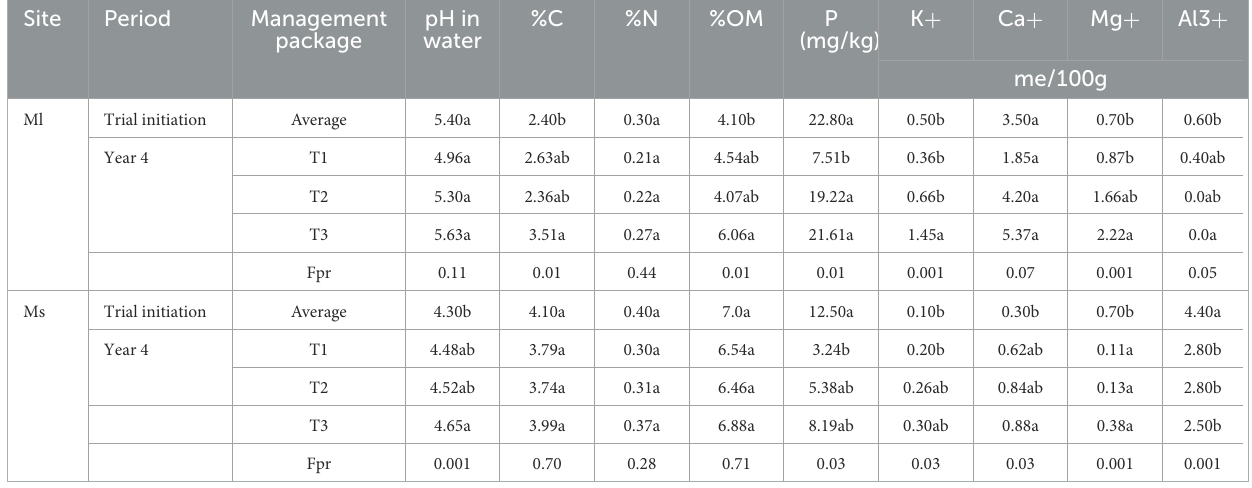
TABLE 4 Soil chemical properties at trial initiation and during the fourth year of trial at Mulungu (Ml) and Mushinga (Ms) sites in eastern Democratic Republic of Congo.